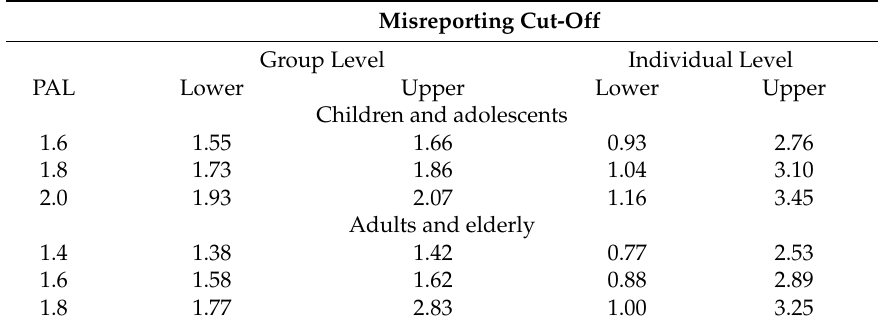
Table 1. CV-WEI (coefficient of variance in energy intake within-subject) for the ANIBES population were 36.6% for children and adolescents and 41.6% for adults, respectively; and S (factor that considers